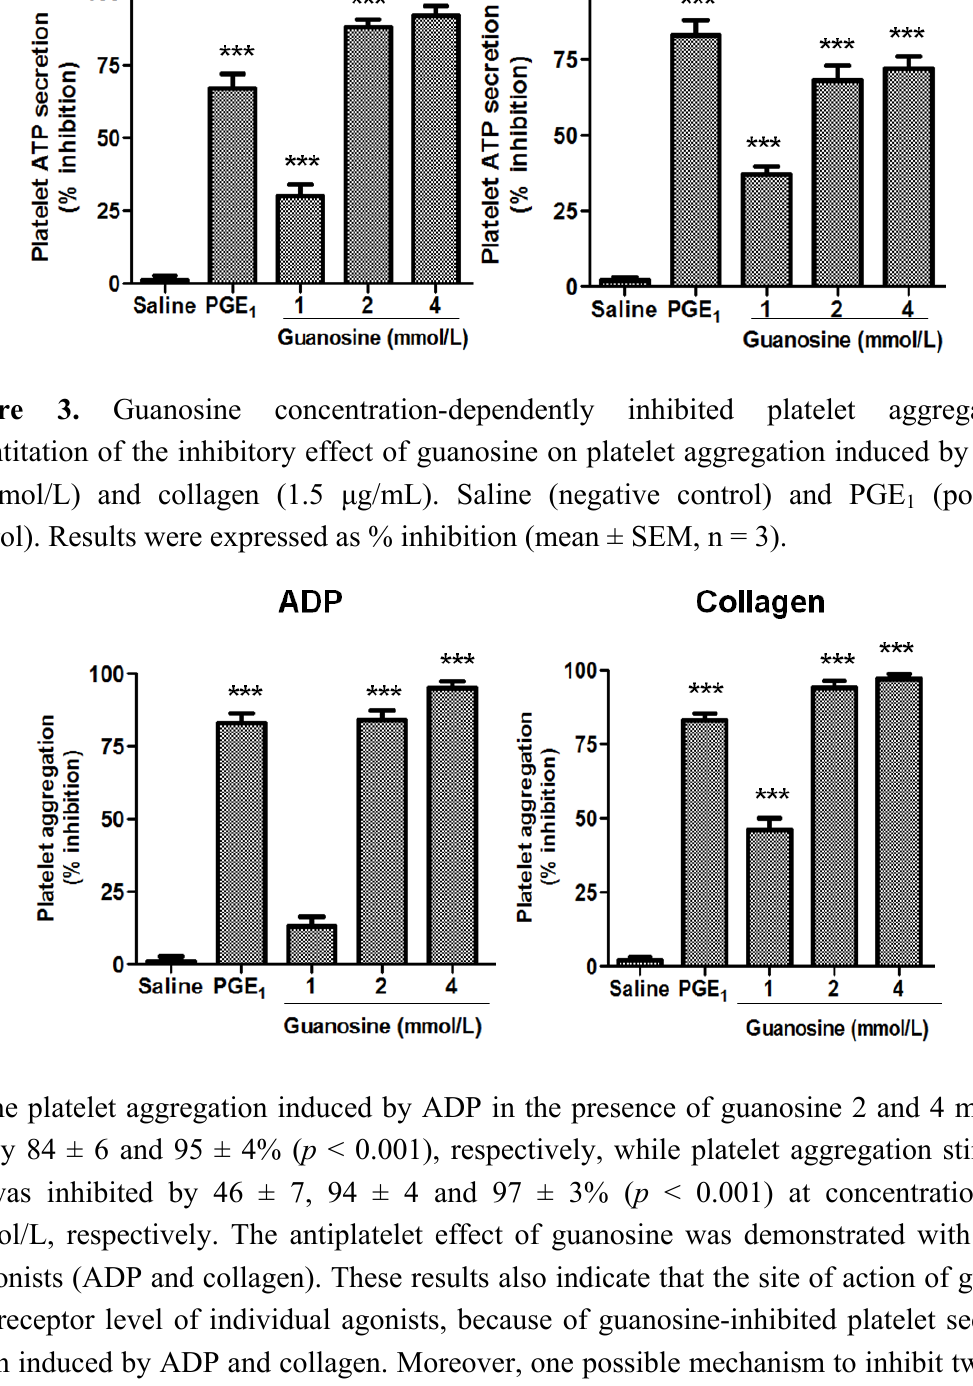
Figure 2. Guanosine concentration-dependently inhibited platelet ATP secretion. Effect of guanosine on ADP (8 µmol/L) and collagen (1.5 μ g/mL) induced platelet ATP secretion. Saline (negative control) and PGE (positive control). Results were expressed as % 1 inhibition (mean ± SEM, n = 3).